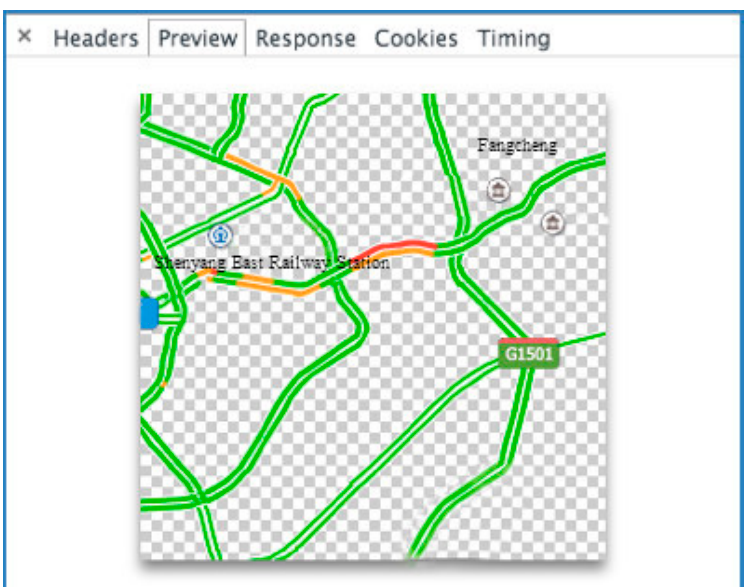
Figure 3. A TCS Figure 3. A TCS graph.